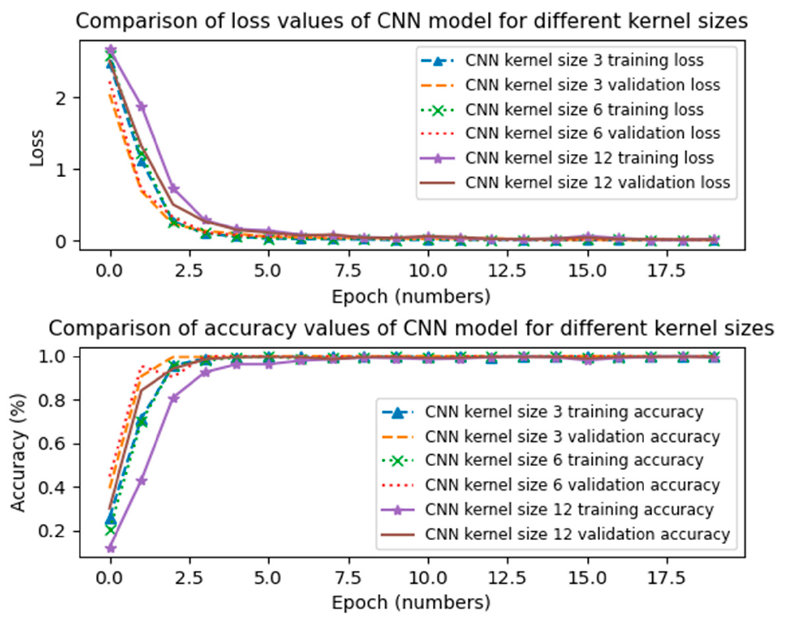
Figure 11. Comparison of performance of 1D CNN model for kernel sizes of 3, 6, and 12.